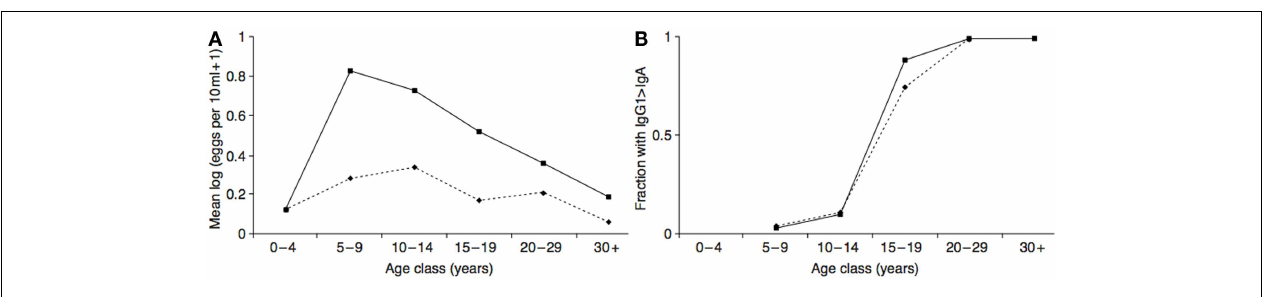
represents fractions of the two populations with high levels of anti-soluble egg antigen specific IgG1 relative to IgA (as absorbance at 492nm). Reproduced from Ref.